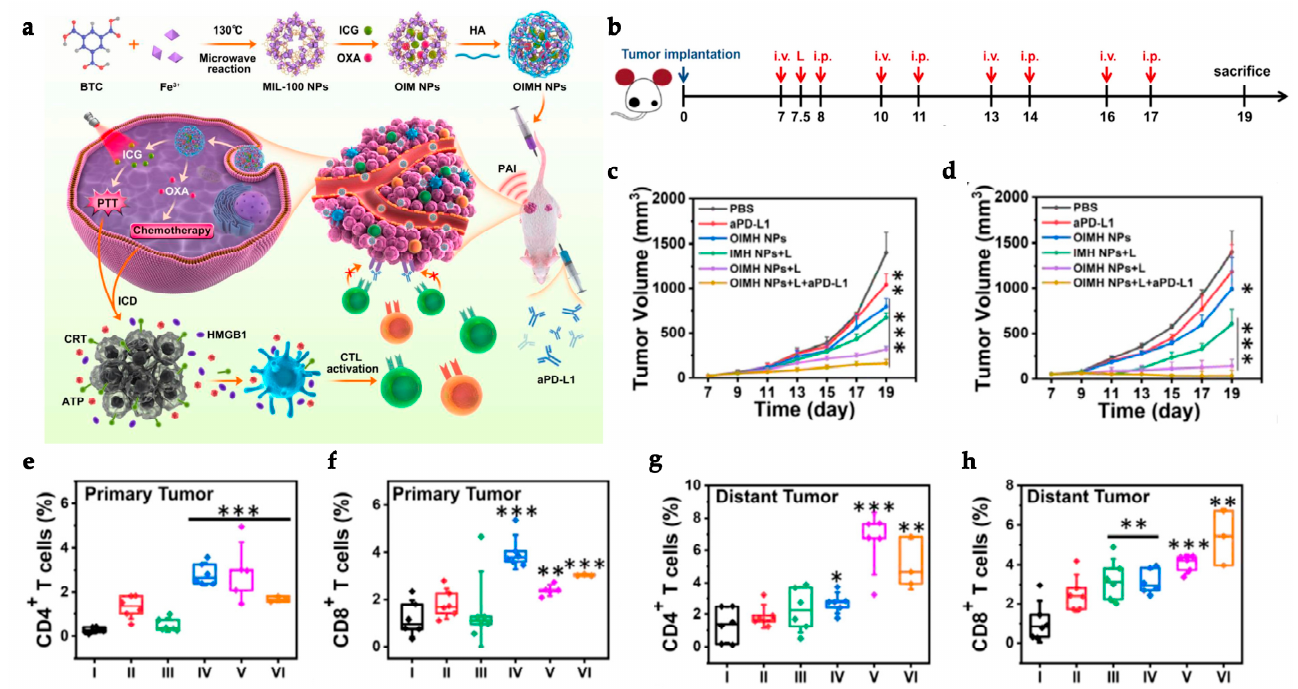
Figure 7. MOF-based synergetic PTT-immunotherapy strategy. ( a ) OIMH NPs were synthesized by loading ICG and OXA into MIL-100 NPs and subsequently coated with HA. OIMH NPs combine PTT with chemotherapy to ensure a robust ICD and subsequent antitumor immune response that can be synergized with ICB therapy. ( b ) CT26 cells were subcutaneously injected in mice and grown to a volume of 150 mm 3 . After day 7, tumor-bearing mice were divided into 5 treatment groups ( n = 6): PBS (I), aPD-L1 (II), OIMH NPs (III), IMH NPs+laser (IV), OIMH NPs+laser (V) and OIMH NPs+laser+aPD-L1 (VI). Laser irradiation (808 nm, 0.8 W/cm 2 , 10 min) has been performed 12h post- injection. ( c , d ) Tumor volume variation of primary ( c ) and distant ( d ) tumors. ( e – h ) Percentage of tumor-infiltrating T Cells: e) CD4 + T cells in primary tumors; f) CD8 + T cells in primary tumors; ( g ) CD4 + T cells in distant tumors; ( h ) CD8 + T cells in distant tumors. Data are shown as mean ± SD ( n = 6). *** p < 0.001, ** p < 0.01, * p < 0.05 [134]. Copyright © 2022, with permission from Elsevier.